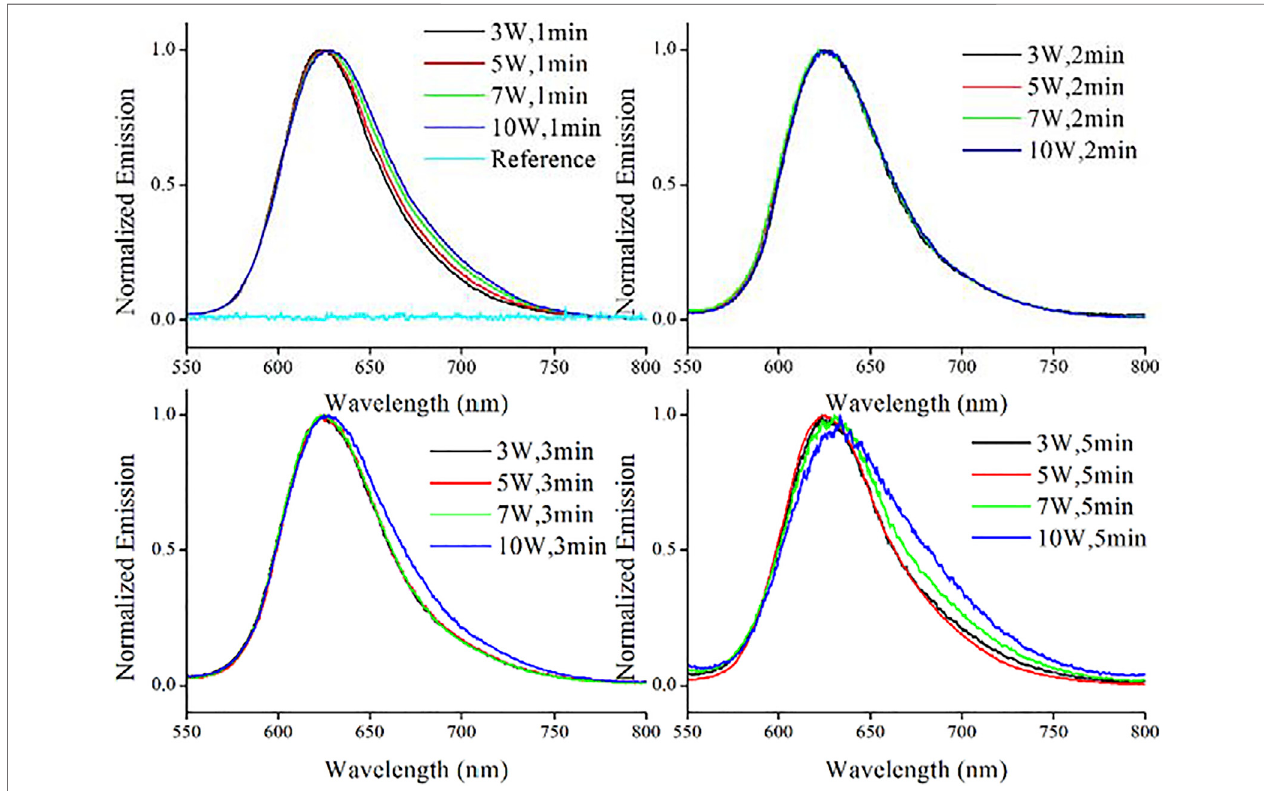
FIGURE1| EmissionspectraofAuNCspreparedundervariousconditionsandareferencesample(pureL-Cystreatedwithmicrowave),dilutedwithpurewater(v: v (cid:1) 1:10).